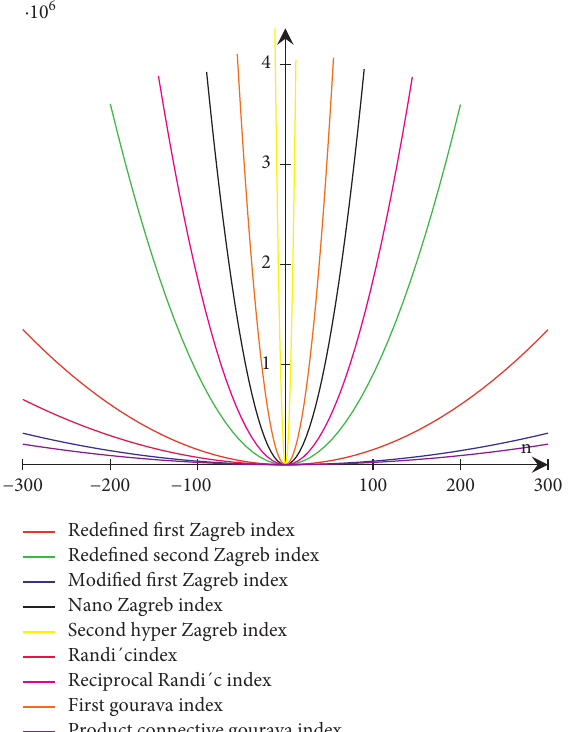
Figure 3: Plot of topological indices of silicate network ( SL